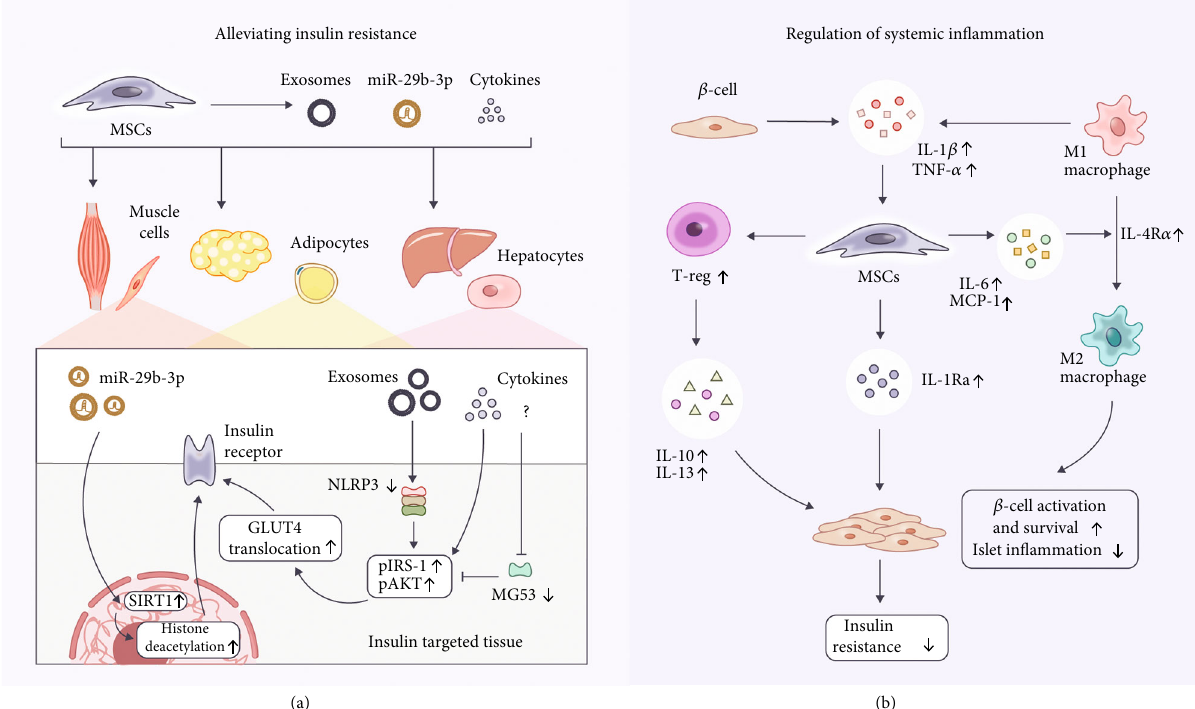
Figure 2: (a) Possible mechanisms of action for MSCs on insulin target organs to alleviate insulin resistance. Exosomal miR-29b-3p can regulate cellular insulin sensitivity via SIRT-1. Furthermore, NLRP3 formation can be inhibited through immune response regulation mediated by MSCs, thus enhancing the function of IRS-1 and GLUT4 in hepatic cells. MSCs also facilitate the inhibition of MG53, which is an E3 ligase that promotes the ubiquitinoylation of IRS-1 in skeletal muscles. (b) Possible mechanisms of action for MSCs to regulate systemic in fl ammation. IL-1 β and TNF- α secreted by the T2DM islet will stimulate MSCs to secrete IL-1Ra, which in turn ameliorates islet in fl ammation. MSCs can also promote the proliferation of Treg cells, and IL-10 and IL-13 secreted by Treg seem to play a key role in islet regeneration by reducing systemic in fl ammation. Besides, classically activated macrophages (M1) could stimulate MSCs to overexpress IL-6 and MCP-1, thus converting M1 into an alternatively activated phenotype (M2) to reduce systemic in fl